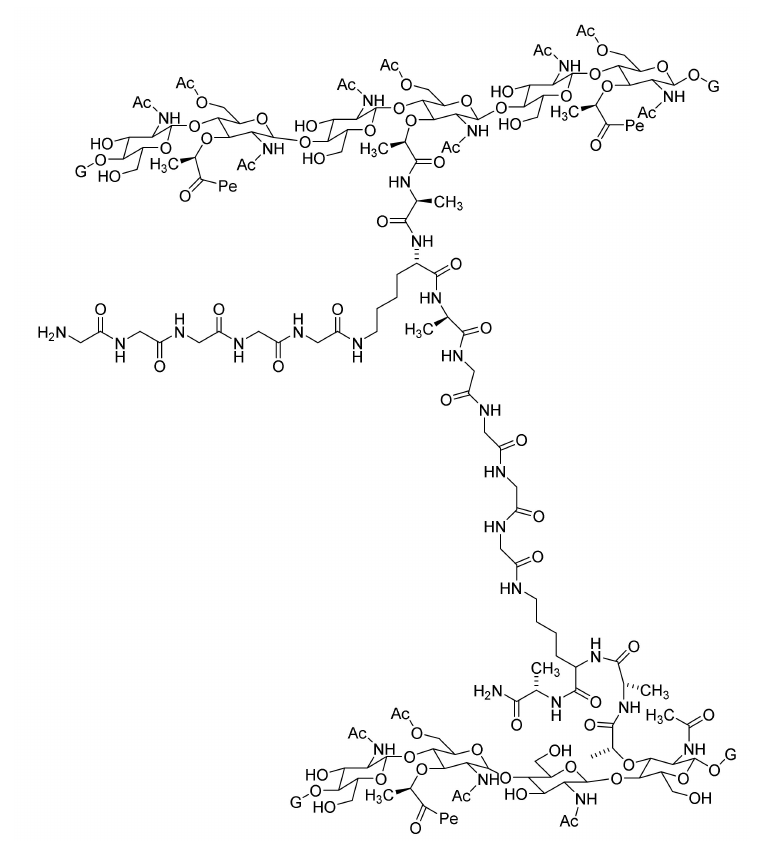
Figure 7. Cartoon illustrating the cross binding of peptidoglycan strands in the cell walls of Staphyl- lococcus aureus [52,58]. Pe indicates the attachment of an additional cross binding peptide by a peptide bond to N -acetymuramic acid. G indicates prolongation with other units of the dimer N -acetylglucosamine- N -acetylmuramic